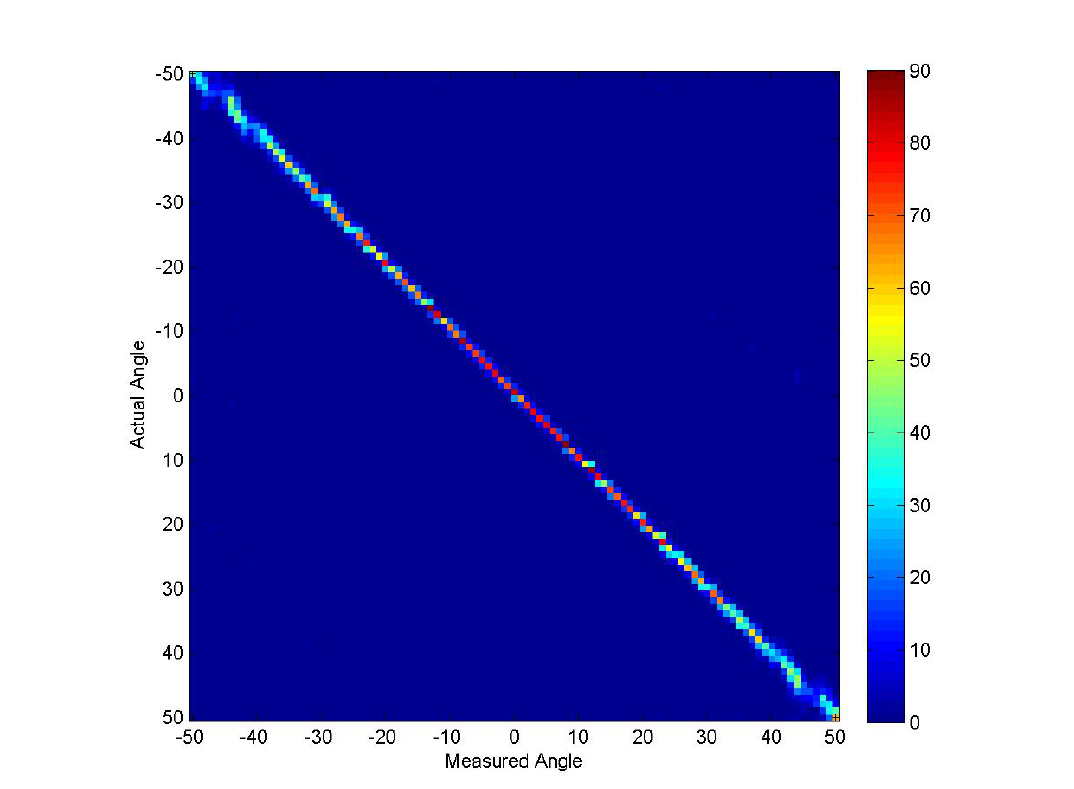
Figure 9. Ambiguity plot for Experiment 2 (13-dB threshold).